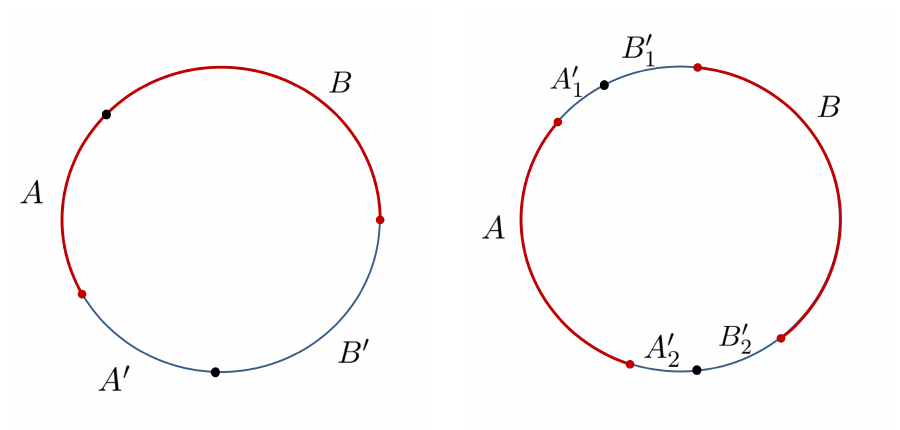
Figure 1: The purification of a region AB is given by ABB (cid:48) A (cid:48) for adjacent (left) and non-adjacent (right) intervals. When the intervals are adjacent the auxiliary system A (cid:48) B (cid:48) consists of A (cid:48) B (cid:48) = A (cid:48) ∪ B (cid:48) . One the other hand, for the non-adjacent case, the auxiliary system A (cid:48) B (cid:48) consists of A (cid:48) B (cid:48) = A (cid:48)